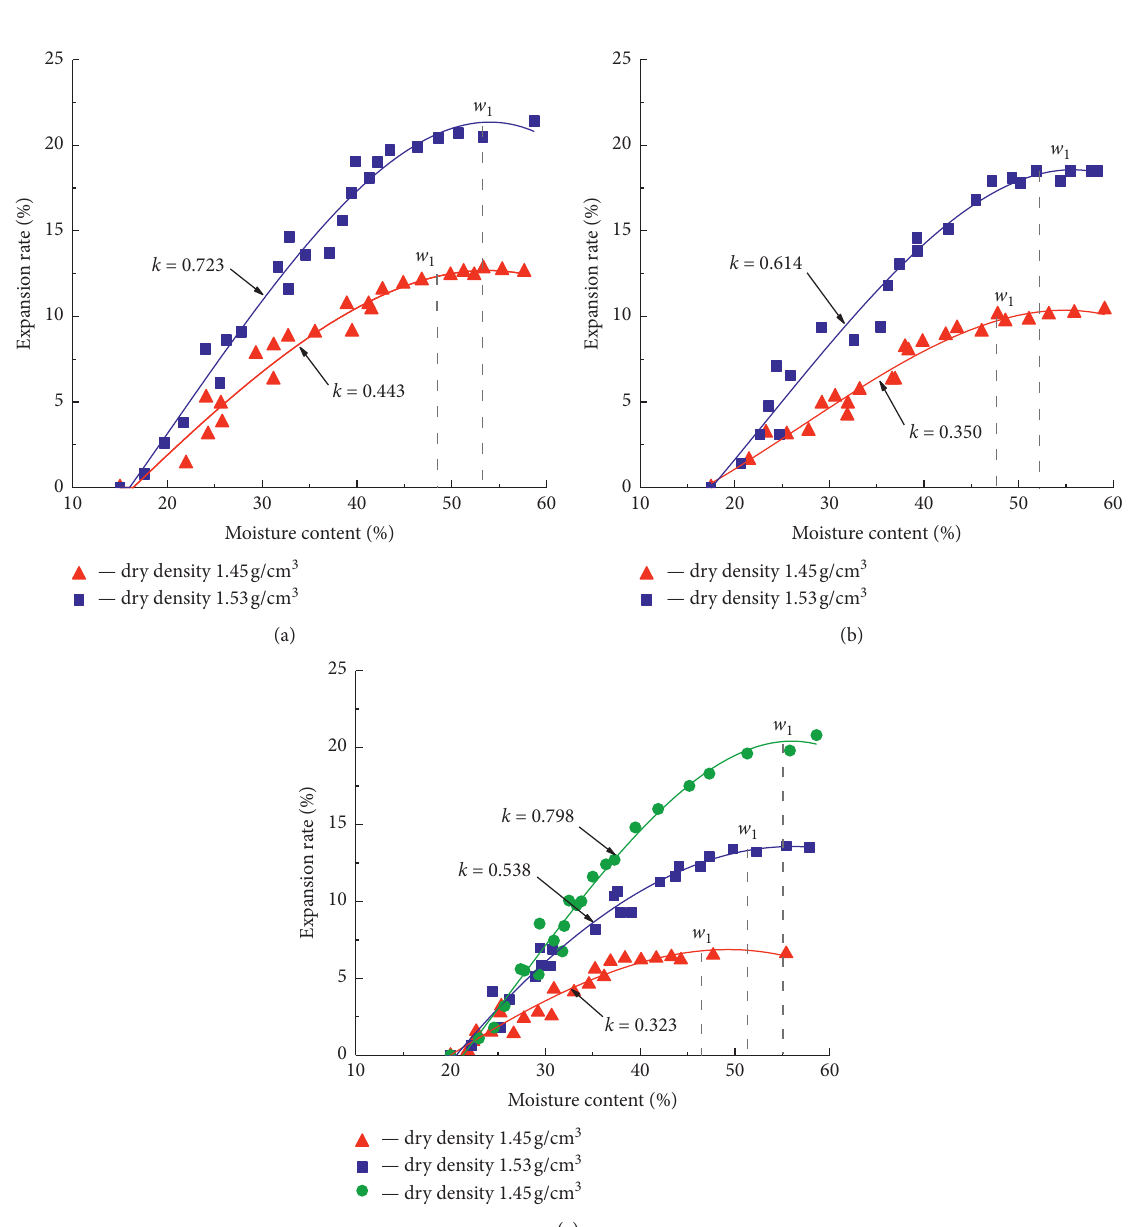
Figure 2: The relationship between the free load swelling rate and the initial moisture content. (a) Initial moisture content 15%, (b) initial moisture content 17.5%, and (c) initial moisture content